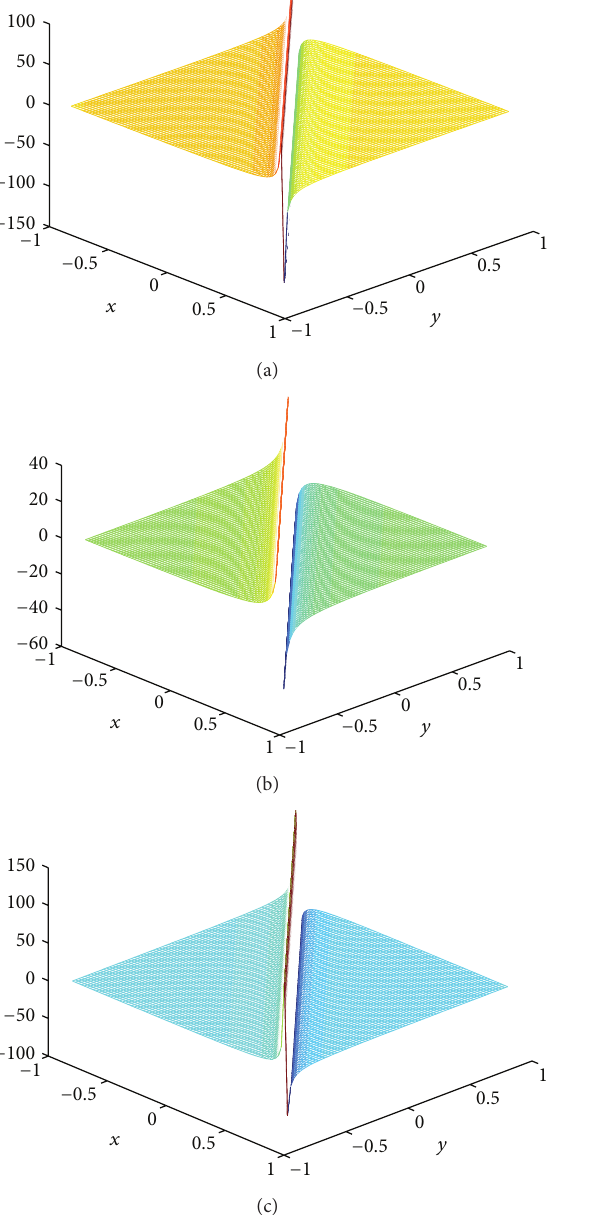
Figure 2: The solution of BLP corresponding to 𝑢 𝑠,2 : take 𝑐 = 1 , = 0 ; (a) 𝑡 = −1/115 , (b) 𝑡 = 0 , and (c) 𝑡 = 1/115 . 𝛼 = 1 , 𝑧 0